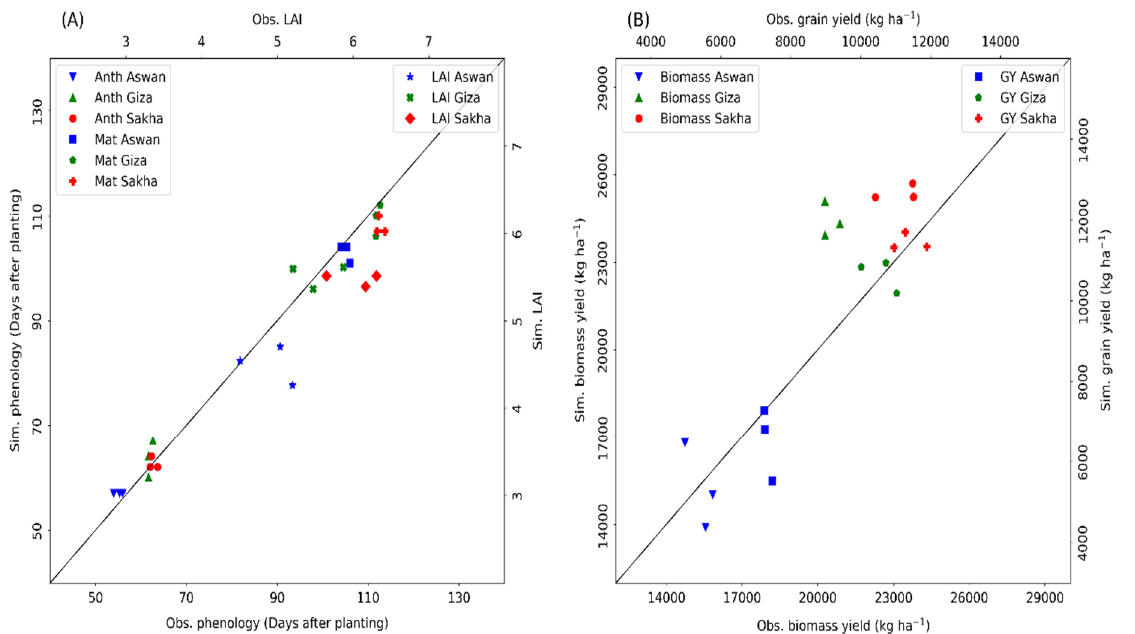
Figure 3. ( A ) Model evaluation for maize phenology and leaf area index and ( B ) maize biomass and grain yields at three different locations shown in Figure 2. Each feature (location, color) represents two cultivars (SC10 and TWC324) and three growing seasons (2018, 2019, and